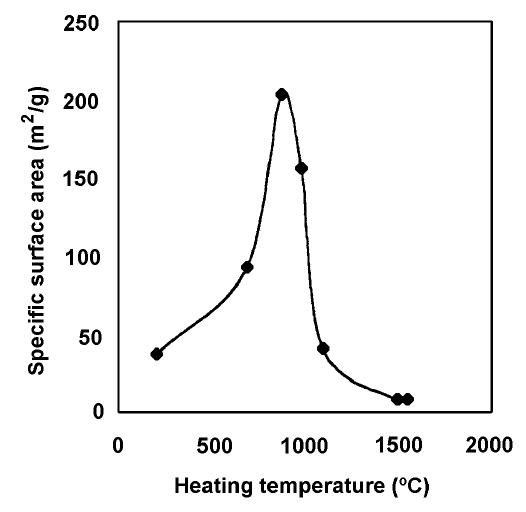
Fig. 11 – Specific surface area ( m 2 /g ) of the aluminas from heating aluminium hydroxiacetate crystals in the range of 200 ◦ C and 1500 ◦